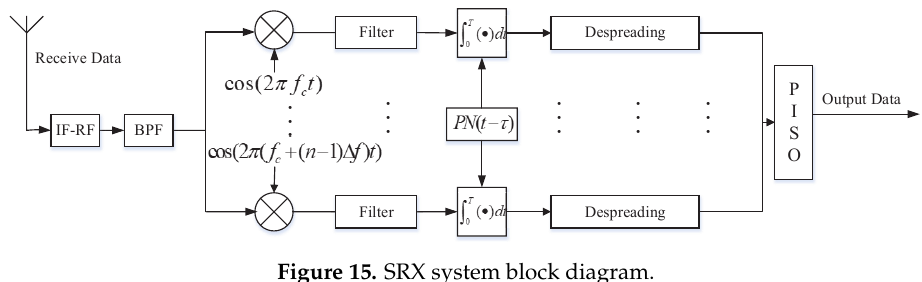
Figure 15. SRX system block